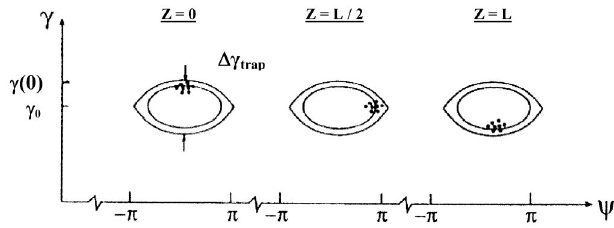
FIG. 10. Optimal (high energy extraction) saturation dynamics of an e -bunch in the prebunched beam FEL